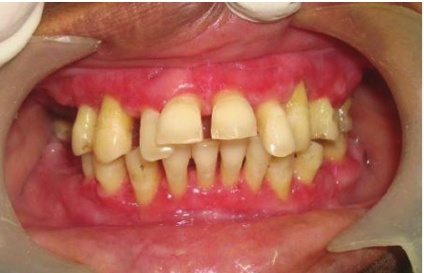
Figure 8: Postoperative view depicting uneventful